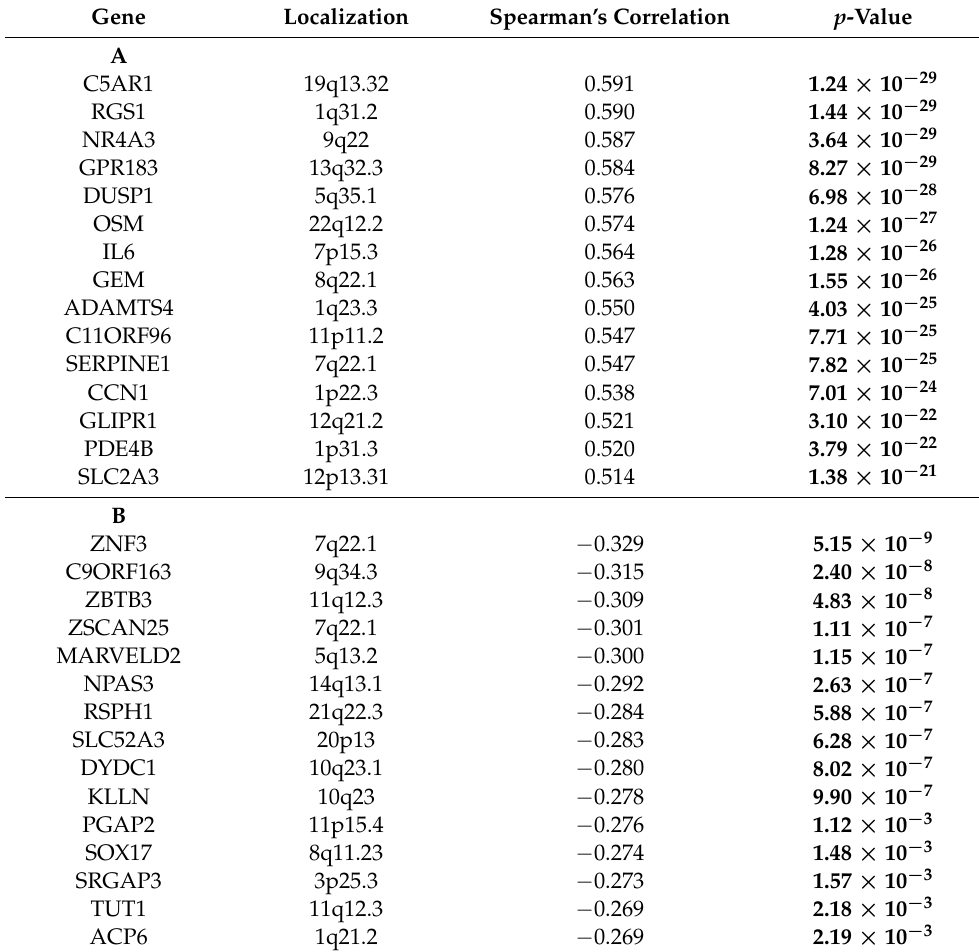
Table 3. Correlation between RGS2 mRNA-Expression and mRNA expression of associated genes in the TCGA cohort ( n = 299). A: TOP 15 genes that are positively correlated with RGS2. B: TOP 15 genes that are negatively correlated with RGS2. C: Co-expression of hallmark-genes for epithelial, mesenchymal translation. D: Hallmark genes for methylation. E: Genes that are associated with downstream signaling of RGS2 and hypoxia. Bold font indicates statistical